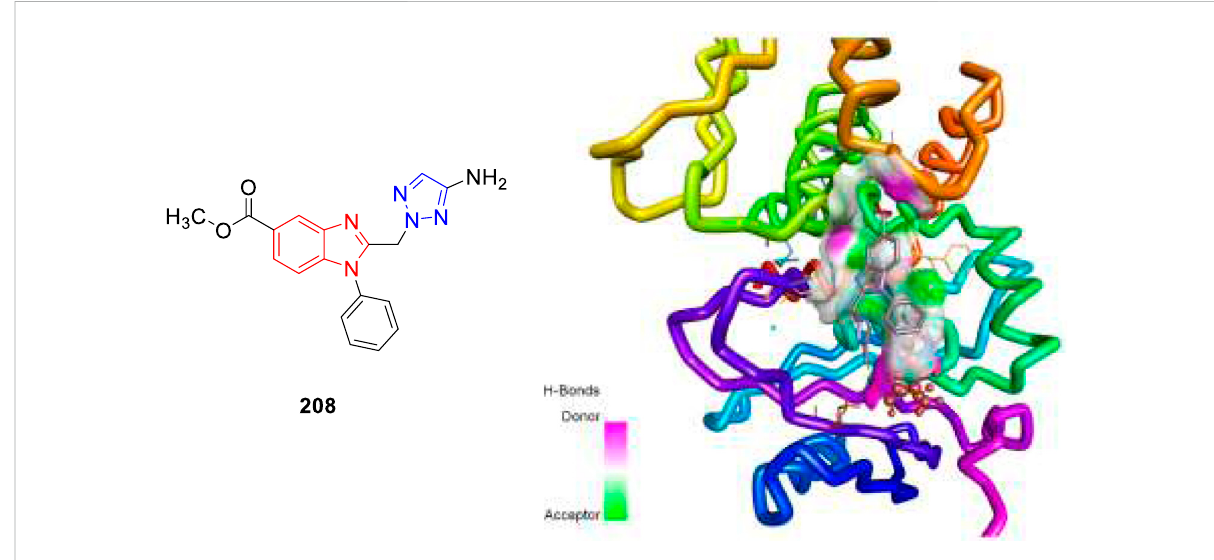
FIGURE 20 Binding pattern of compound 208 with PrpR protein of Mycobacterium